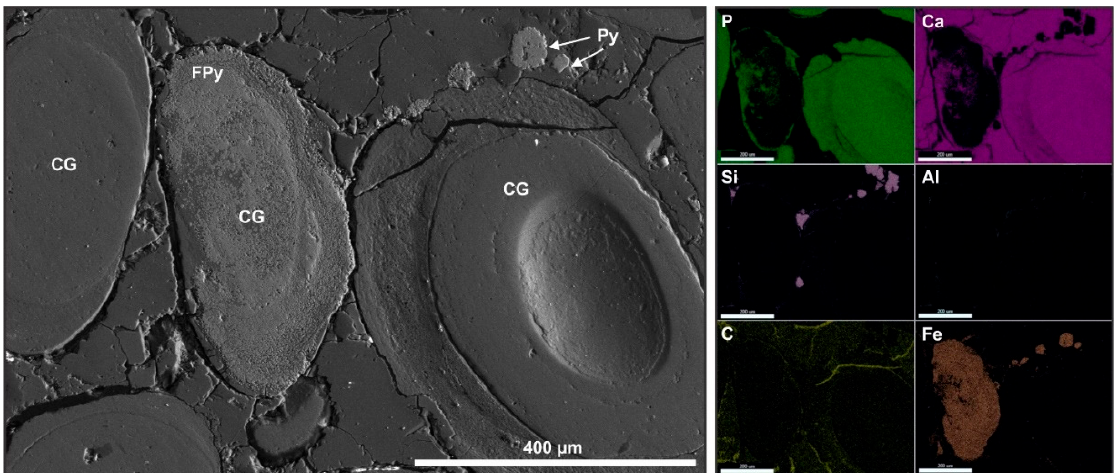
Figure 9. Detailed SEM image of sample CD13 centered on apatite coated grain (CG) with syngenetic framboidal microcrystalline pyrite (FPy), acquired with ET detector BSE mode, and SDD-EDS elemental maps of select major and trace elements. The grain to the left of the center has abundant internal framboidal pyrite, which also occurs around the upper edge of the grain to the right, interpreted as syngenetic. The larger pyrite crystal (Py) near the upper right corner of the image is likely formed during later diagenesis. Solid bitumen can be seen around grain contacts and in fractures.